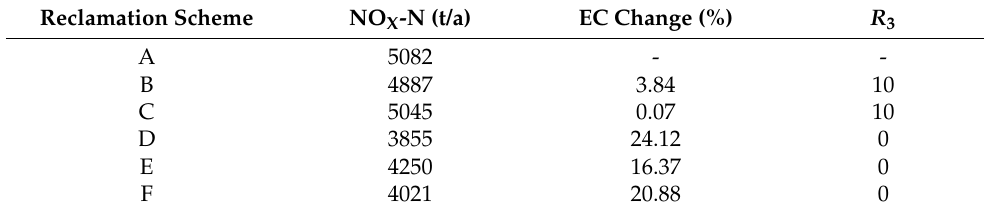
Table 14. Feasibility evaluation in NO X -N environmental capacity.